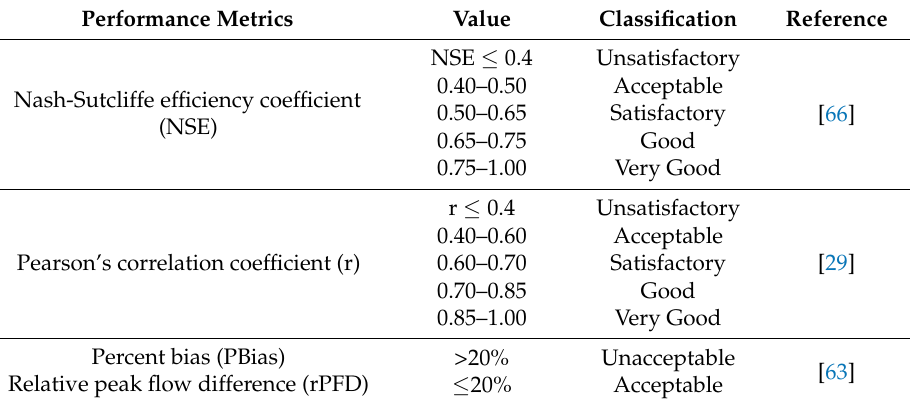
Table 4. Classification of performance for the selected performance